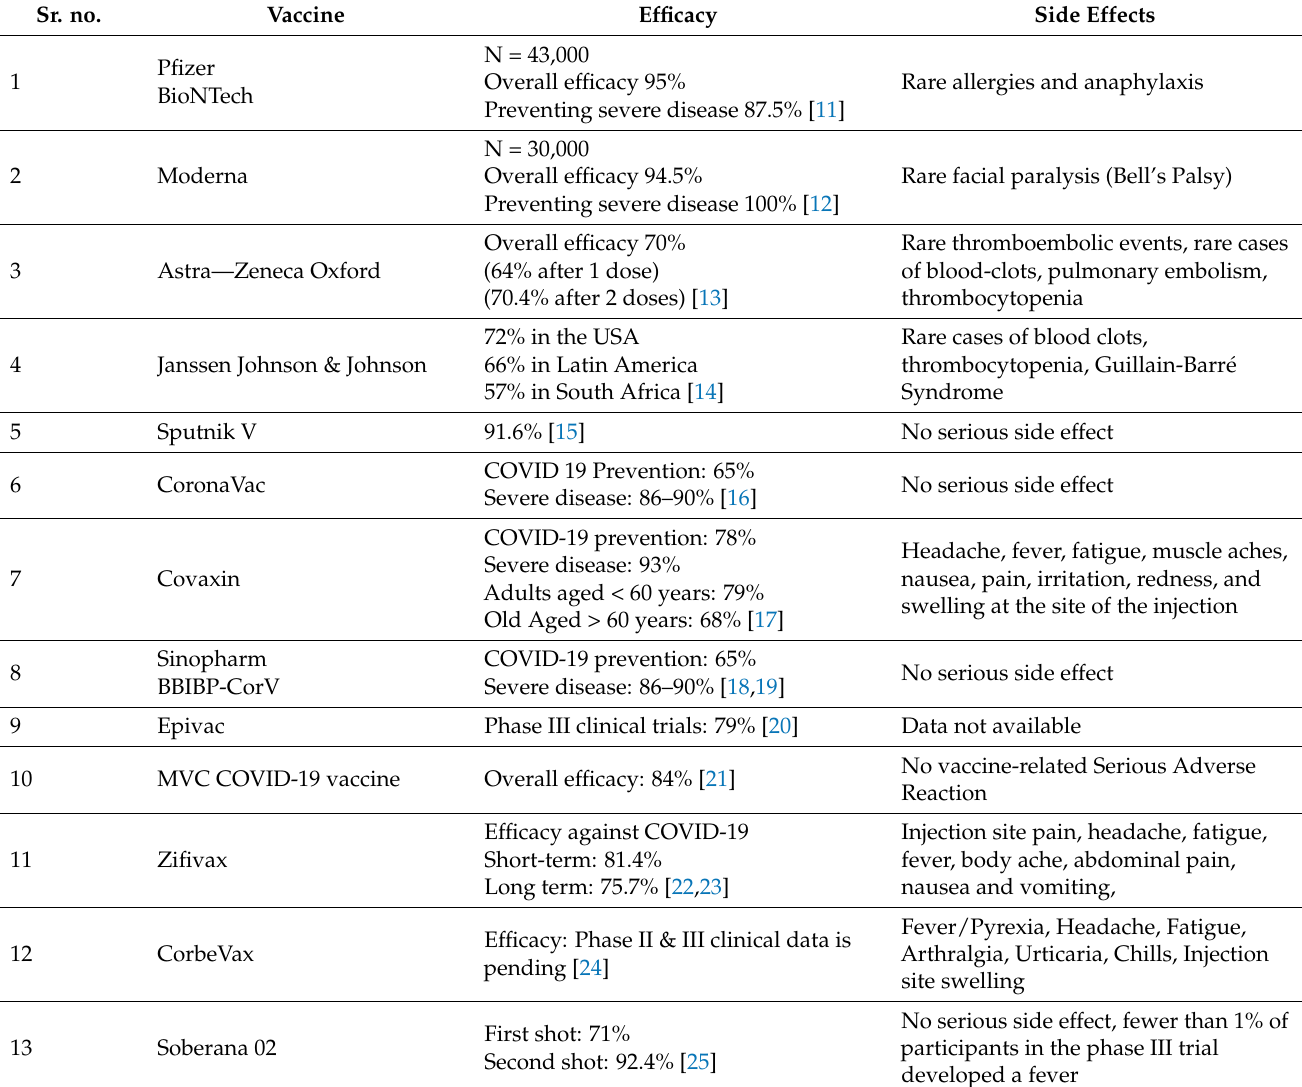
Table 1. Reported efficacy of SAR-Cov-2 vaccine